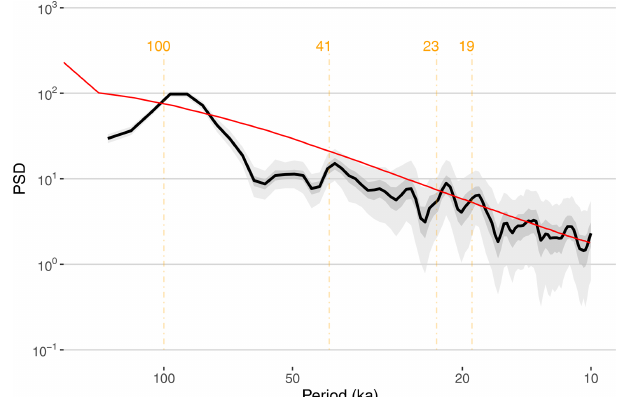
Figure 10. Temperature reconstruction from IODP 846. The me- dian ensemble member is shown in black, with the 50% and 95% highest-density probability ranges shown in dark and light gray, re- spectively.